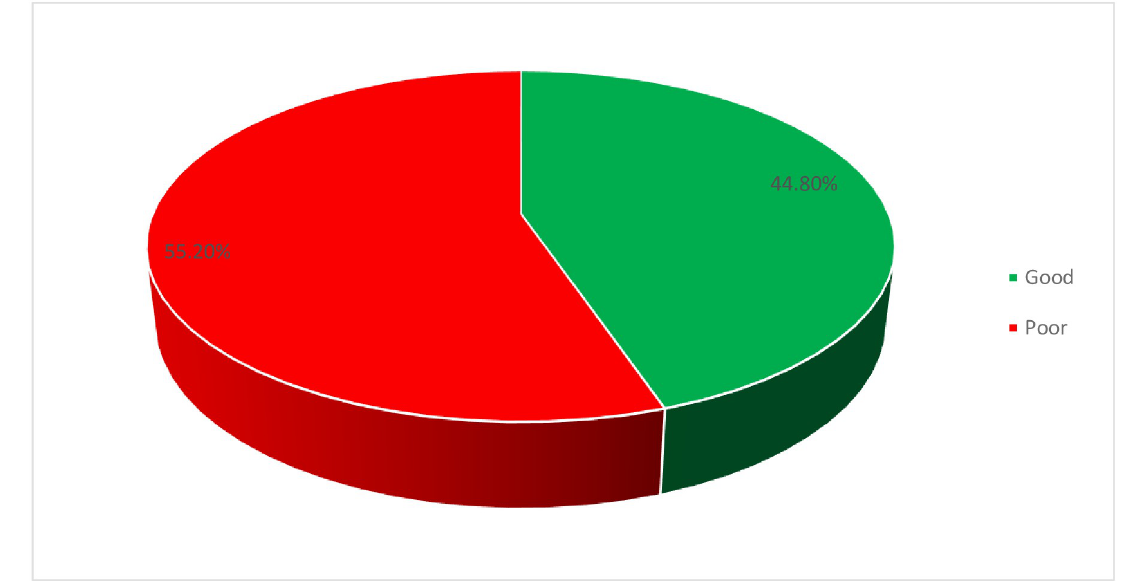
Fig 1. Adherence with COVID-19 preventive practice among pregnant women in Gondar city, northwest Ethiopia, 2021.